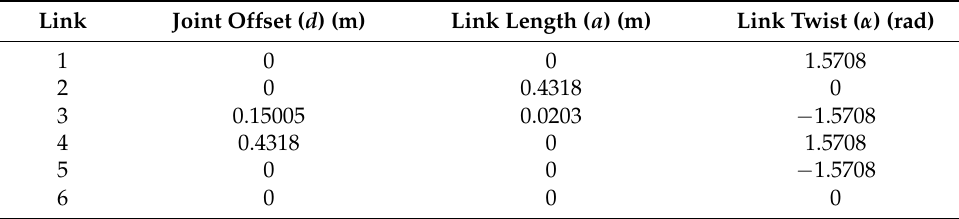
Table 4. Puma560 modified Denavit–Hartenberg (DH) parameters.